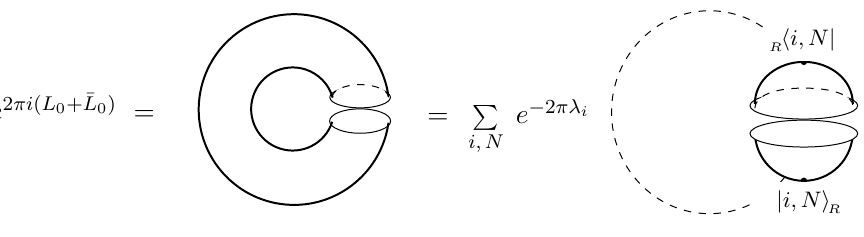
Figure 5 . The evolution operator U = e 2 π ( L 0 +¯ L 0 ) that brings states around the celestial torus can be expanded in states defined via the operator state correspondence of the CCFT on the celestial